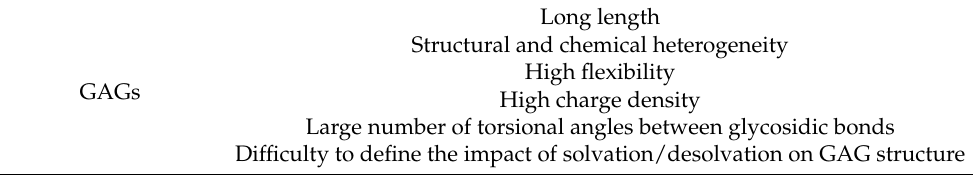
Table 3. Features that makes computational docking of a GAG to a protein a challenging task. Long length Structural and chemical heterogeneity High flexibility GAGs High charge density Large number of torsional angles between glycosidic bonds Difficulty to define the impact of solvation/desolvation on GAG structure Proteins High charge density of GAG-binding sites Absence of well-defined GAG-binding pockets on bound proteins Electrostatic nature of GAG/protein interactions Weak surface complementarity of GAG/protein interactions GAG/Protein Indispensability of solvent for their interactions Complexes Impact of solvation/desolvation on GAG/protein complexes Difficulty to reproduce in silico the specific microenvironment and/or Biological setting in which GAG/protein interactions